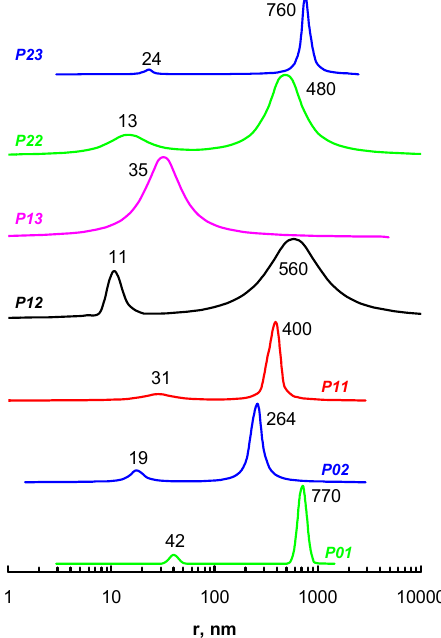
Figure 6. Dynamic light scattering (DLS) data for aqueous solutions of amine-containing polymers at pH 7.4 and a concentration of 2 g · L − 1 . The polymer abbreviations and peak positions are indicated near the curves.